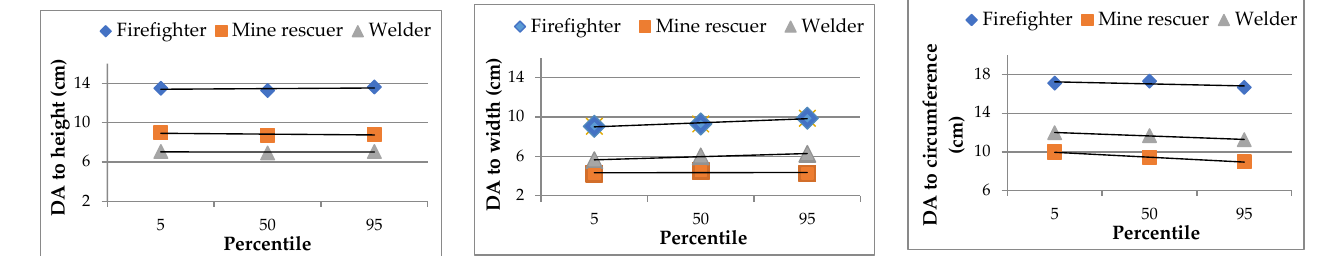
Figure 5. Mean DAs arising from the use of three types of PPE kits for three groups of participants defined on the basis of the 5th, 50th, and 95th percentiles.